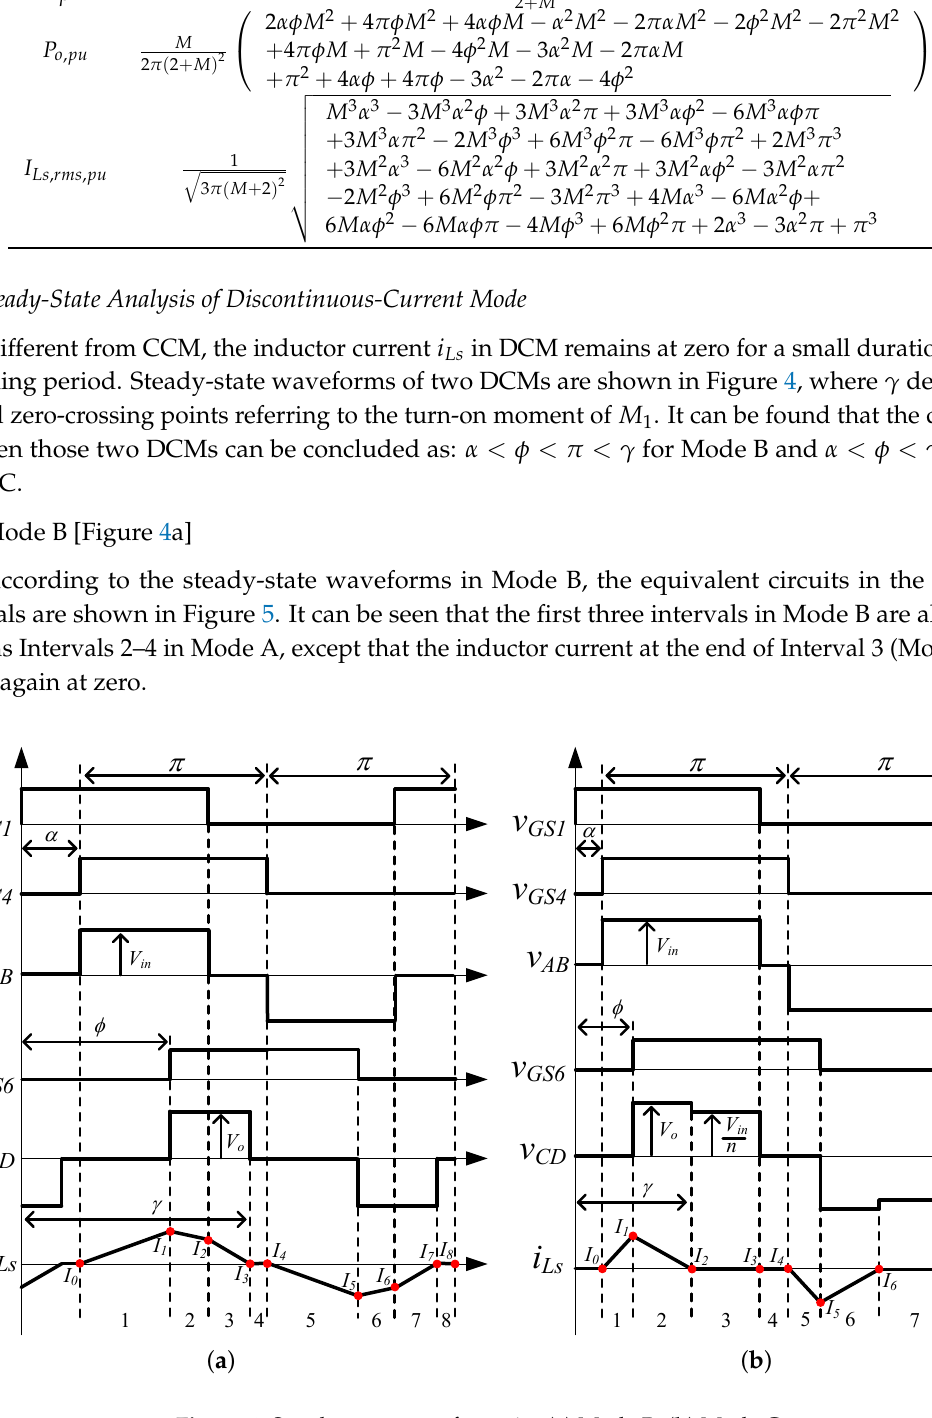
Figure 4. Steady-state waveforms in: ( a ) Mode B; ( b ) Mode